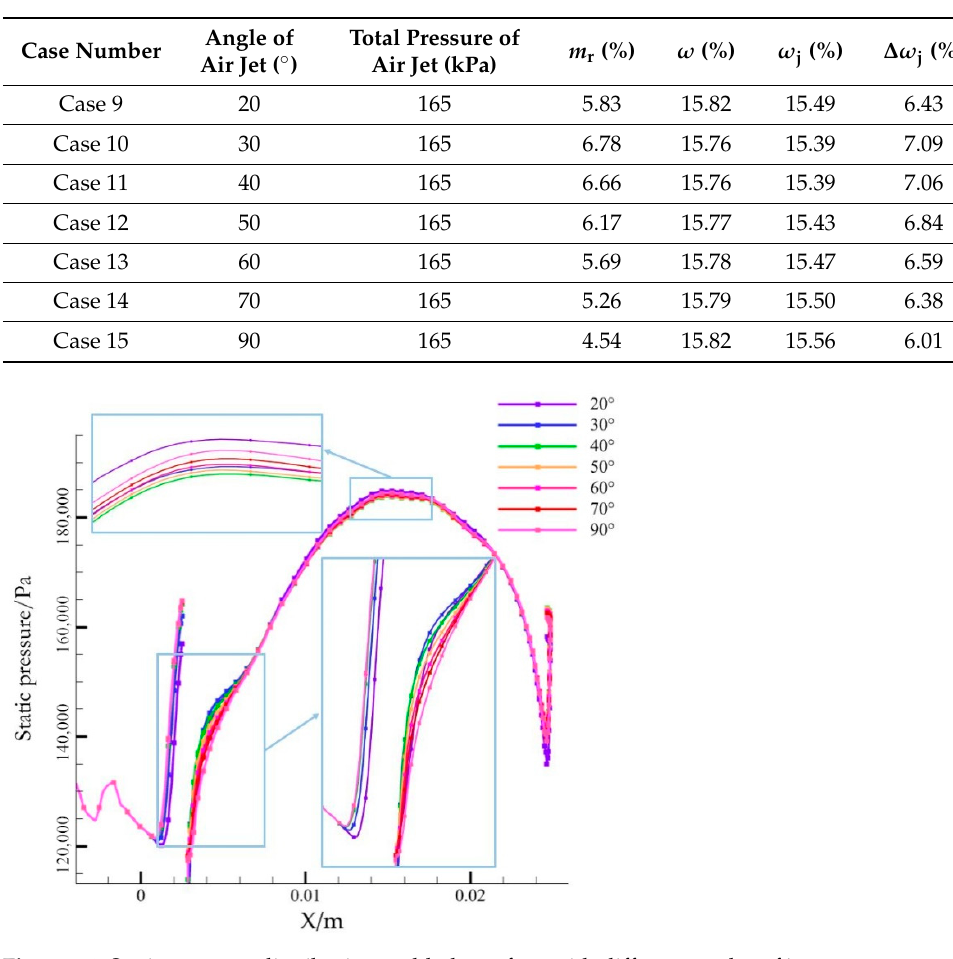
( b ) Figure 15. Static pressure contours with different angles of jet: ( a ) 𝛼 = 20° ; ( b ) 𝛼 = 40° . 3.3. Discussion As can be seen from Section 3.2, suitable jet parameters can further change the shock structure, thereby reducing shock loss. Shock structure is closely related to boundary layer. Figure 16a shows a simplified model of trailing-edge shock. Near the pressure side